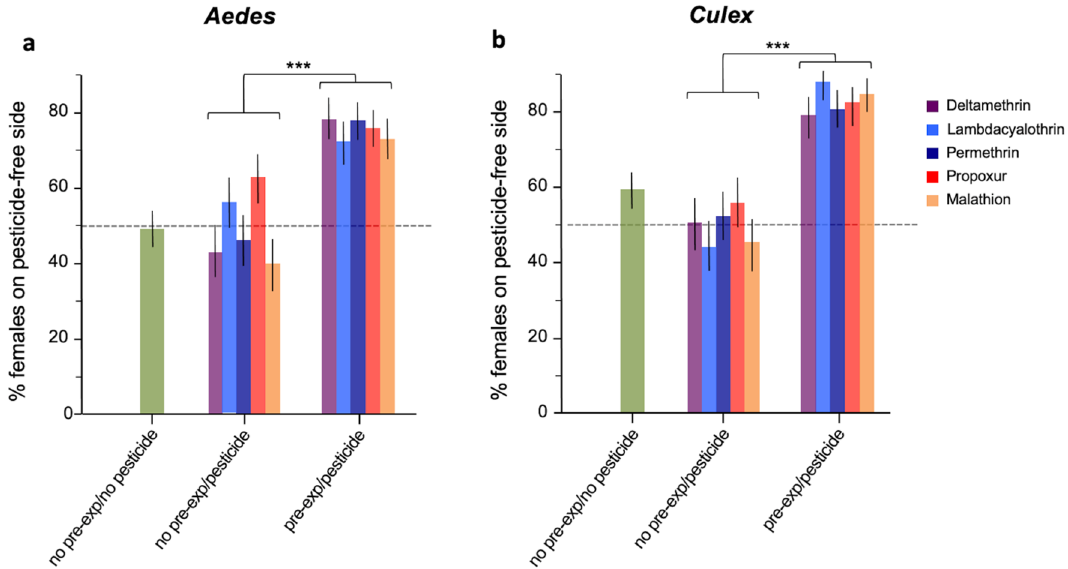
Figure 4. Proportion unconditioned and conditioned females of ( a ) Aedes aegypti and ( b ) Culex quinquefasciatus resting in the pesticide free side when faced to the choice compartments with pesticide smell and no pesticide smell. Error bars represent 95% confidence intervals. P values are P < 0.001 ***.